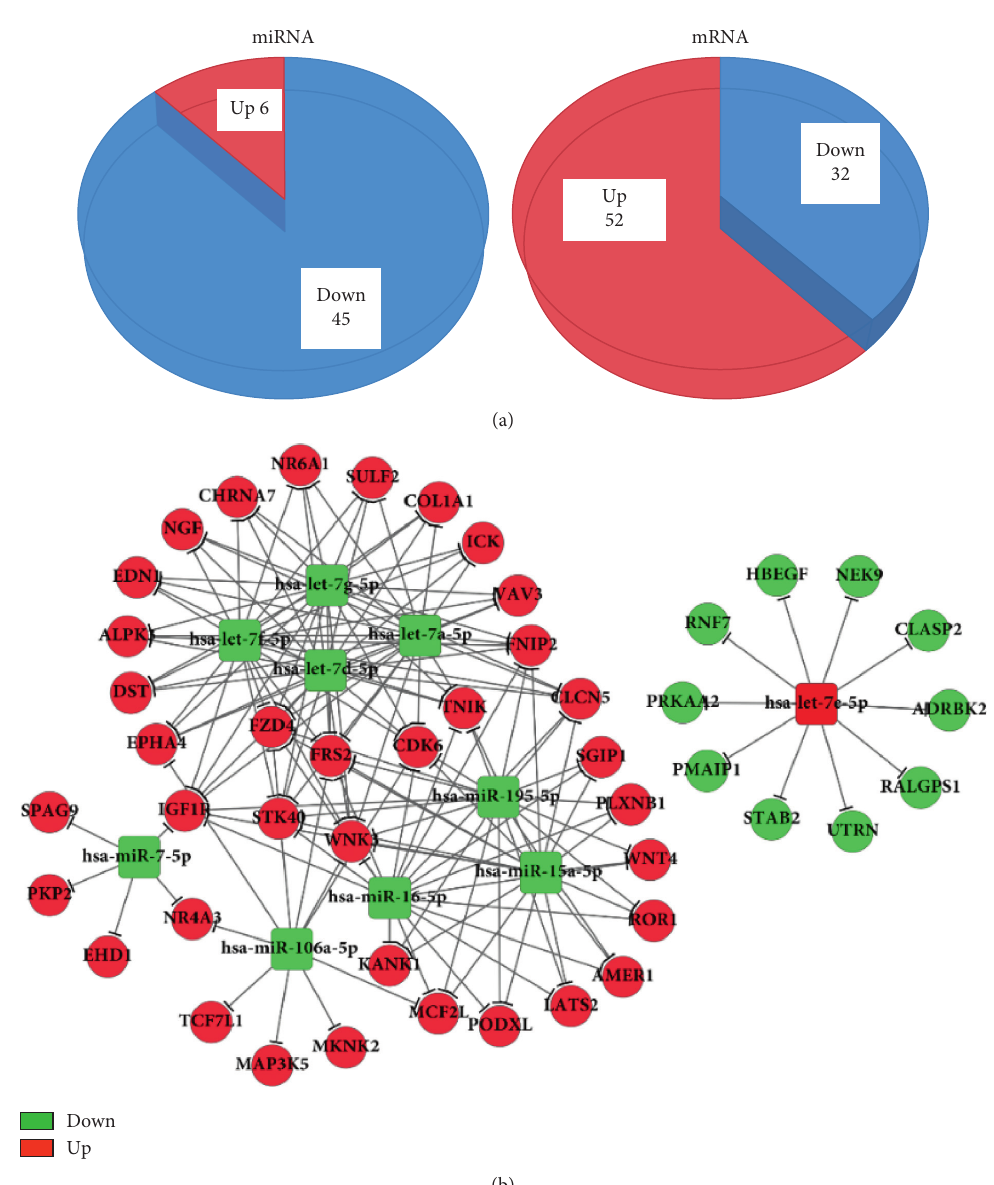
Figure 4: Results of miRNA chip and mRNA expression profiles after si-TET1 in BCPAP cells. (a) The expression of miRNAs and mRNAs was analyzed in NC and si-TET1 RNA groups in BCPAP cells. The fold change of miRNAs and mRNAs were set to be two times and 1.5 times, respectively, indicating obvious differences. The red ones are upregulated, and the green ones are downregulated. (b) Regulatory network map of classical oncogenes miR-7 and miR-15/16 and let-7. The statistically differentially expressed miRNAs are labeled in squares, and the statistically differentially expressed mRNAs are labeled in circles. The upregulated expression is shown in red, and the down- regulated expression is shown in